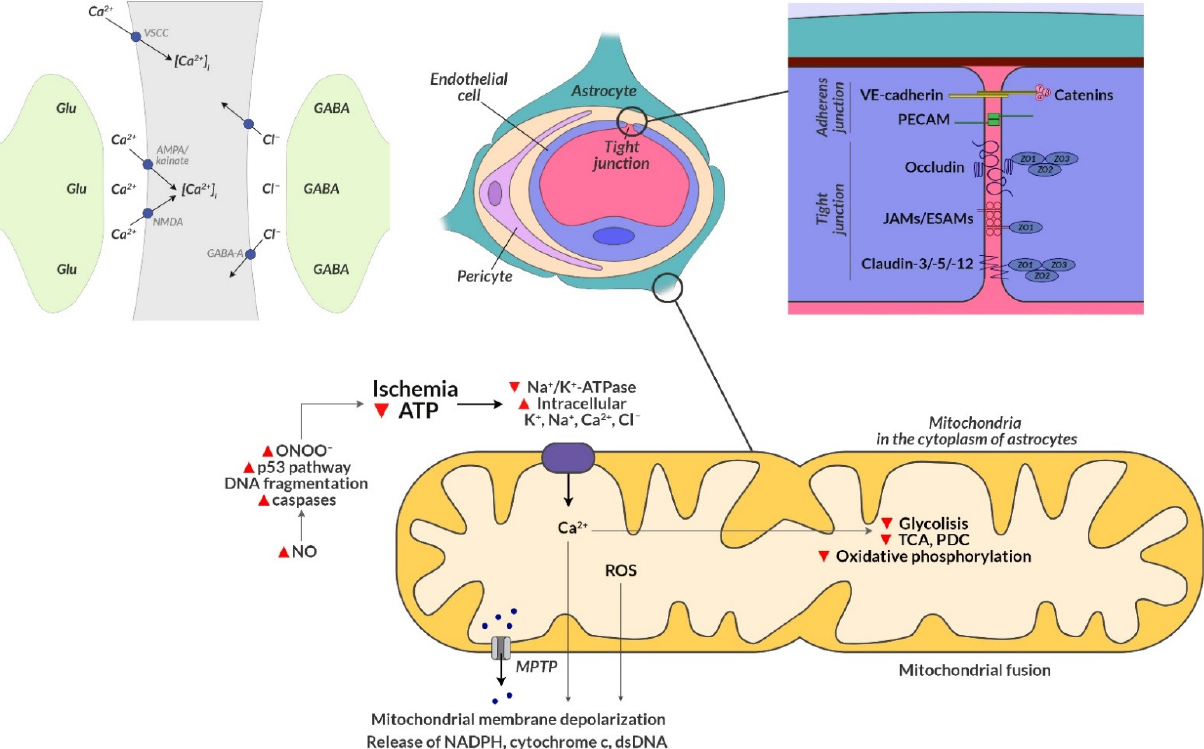
Figure 1. The response of astrocytic mitochondria to hypoxia in the course of ischemic stroke. AMPA: α -amino-3-hydroxy-5-methyl-4-isoxazole propionate; dsDNA: double-stranded DNA; ESAM: endothelial cell-selective adhesion molecule; GABA: γ -aminobutyric acid; Glu: glutamate; JAM: junctional adhesion molecule; MPTP: mitochondrial permeability transitional pore; NADPH: nicotinamide adenine dinucleotide phosphate; NMDA: N-methyl-d-aspartate; NO: nitric oxide; PDC: pyruvate dehydrogenase complex; PECAM: platelet-endothelial cell adhesion molecule; ROS: reactive oxygen species; TCA: tricarboxylic acid; VE: vascular epithelium; and VSCC: L-type voltage-sensitive calcium channels, calcium influx, and overload upon hypoxia.